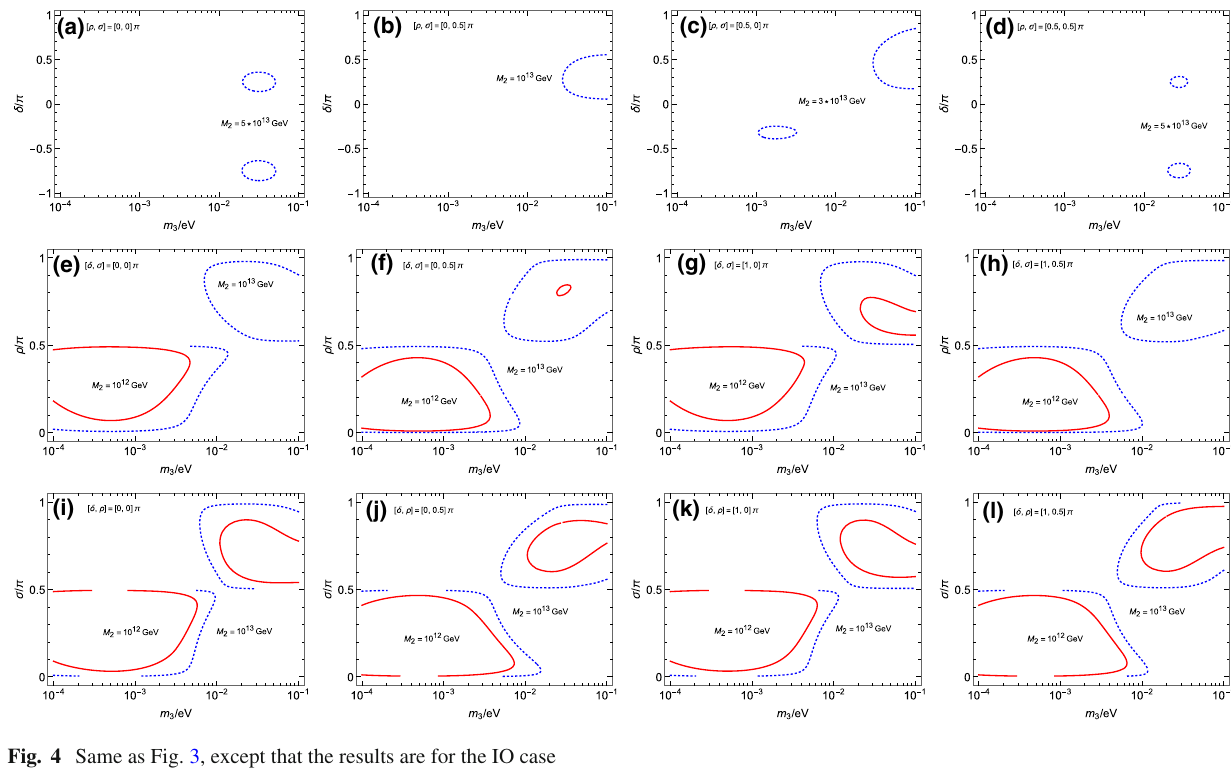
Fig. 4 Same as Fig. 3, except that the results are for the IO case